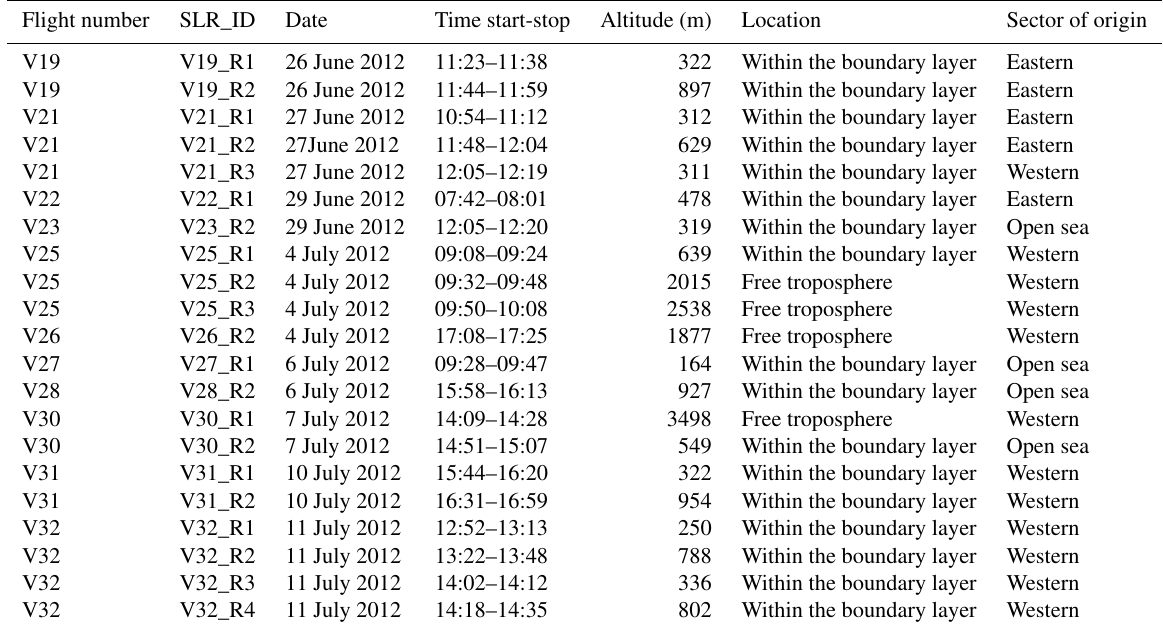
Table 1. Summary of information on the SLRs analysed in this study. The SLR location (within the boundary layer or in the free troposphere) was determined based on the boundary layer top height estimated for the closest vertical sounding performed during each flight (see Sect. 3.3). The sector of origin for sampled air masses was determined based on FLEXPART back-trajectories (see Fig. 1 and Sect. 3.4 for further